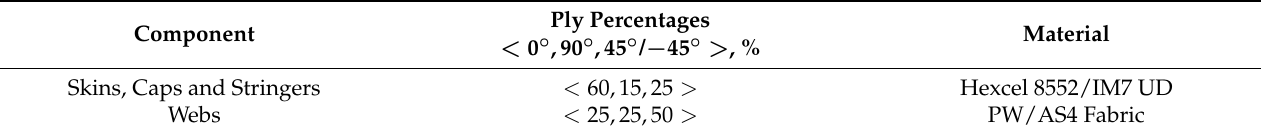
Figure 5. Optimization zones for the SBO framework. Table 2. Laminate percentages and materials applied at the SBO.